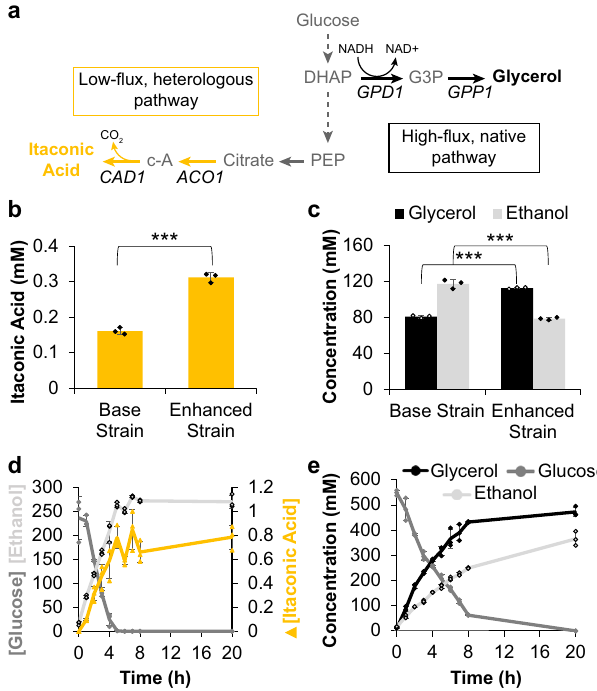
Fig. 4 Cell-free reactions with extract from engineered yeast strains enable production of diverse metabolites. a Metabolic map showing the conversion of glucose to glycerol via dihydroxyacetone phosphate (DHAP) and glycerol-3-phosphate (G3P) or itaconic acid via citrate and cis- aconitate (c-A). b , c Initial cell-free reaction conditions con fi rm that strains engineered for increased product titers result in cell extracts with greater fl ux toward products of interest (*** p ≤ 0.001 compared to base strain). From a two-tailed Student ’ s t -test, p = 8.45 × 10 − 5 for itaconic acid, p = 7.16 × 10 − 6 for glycerol, and p = 2 × 10 − 3 for ethanol. d - e Yeast cell- free reactions with optimized conditions rapidly convert glucose into products, resulting in comparable concentrations to in vivo efforts in signi fi cantly less time. Data represent mean ± standard deviation of n = 3 technical replicates, and time courses represent separate samples quenched at each time point. Source data are provided as a Source Data fi